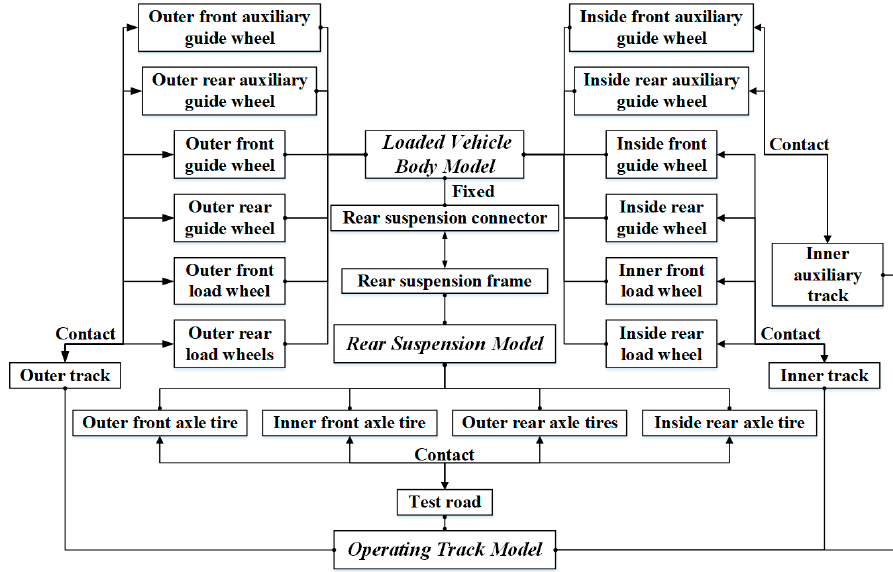
Figure 2. The relationship of sub-models of NE-ALT.